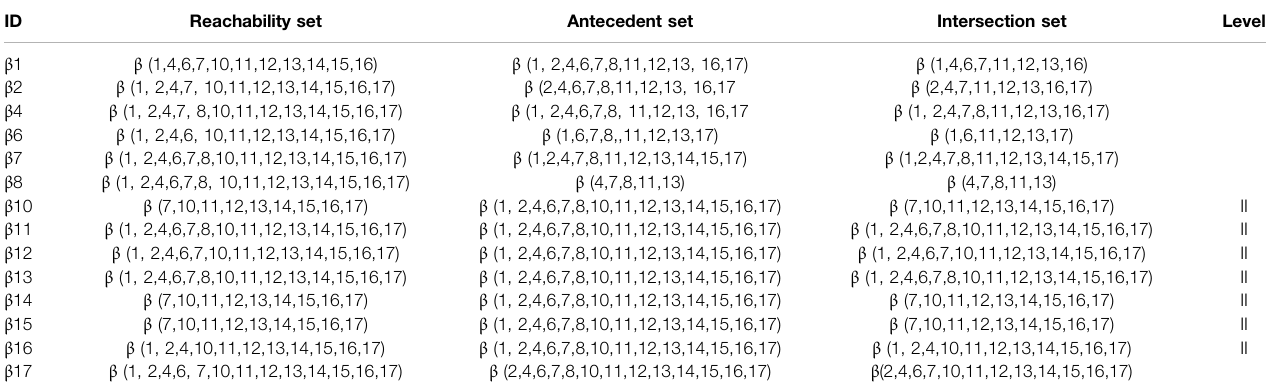
TABLE 8 | Partition level II.